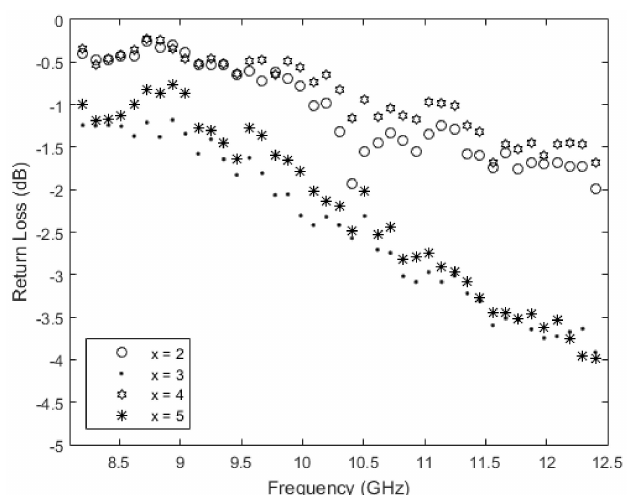
Figure 8. Frequency dependencies of reflection for S r0.3 Ba 0.4 Pb 0.3 Fe 12 O 19 /(CuFe 2 O 4 ) x composite samples (x = 2, 3, 4 and